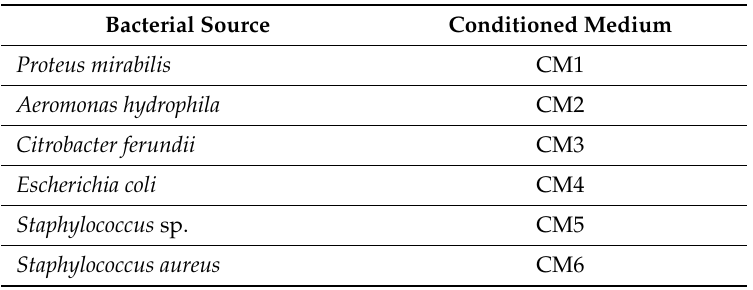
Table 1. Bacterial species isolated from the gut of water monitor